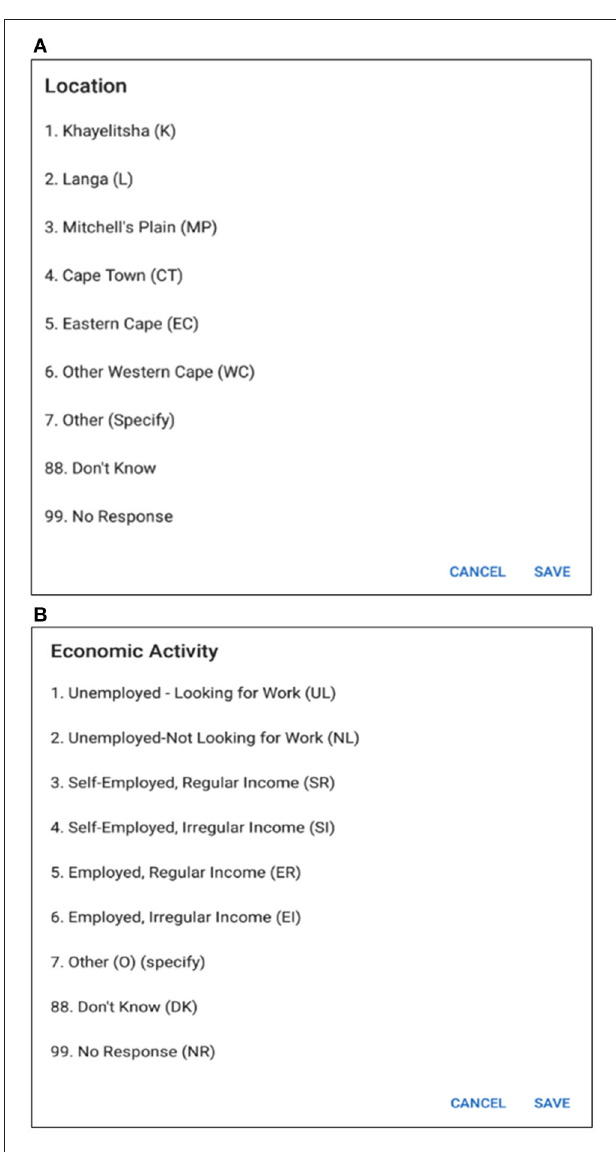
FIGURE 8 | (A) Options for location. (B) Options for economic activity.